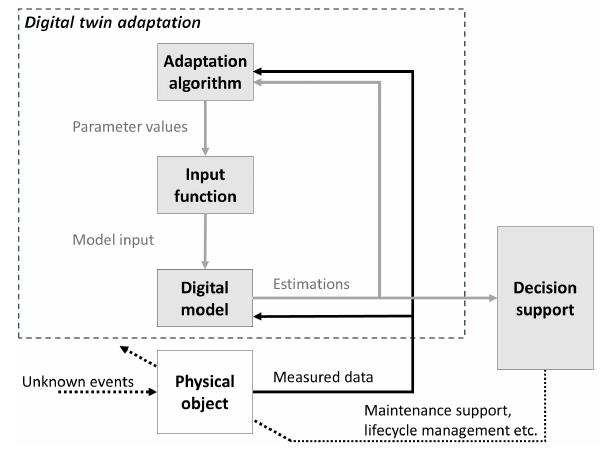
Figure 3: Schema for online adaptation of digital